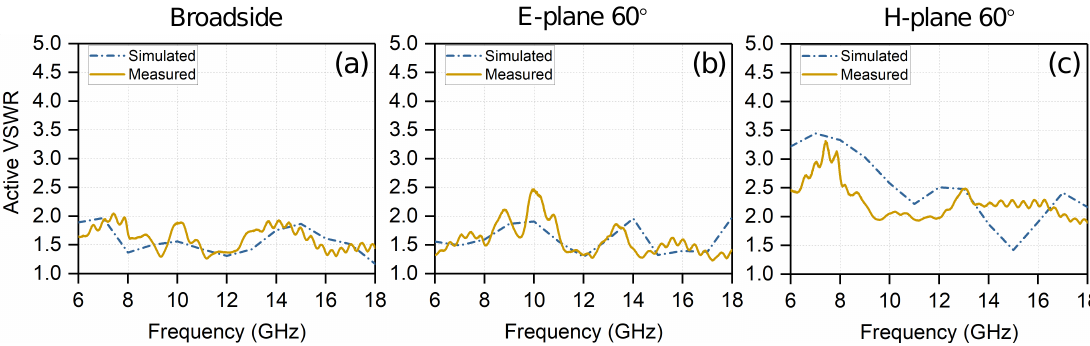
Figure 14. Simulated and measured active VSWR versus frequency and scan angle for the embedded element within the proposed array. ( a ) Broadside; ( b ) E-plane 60 ◦ ; ( c ) H-plane 60 ◦